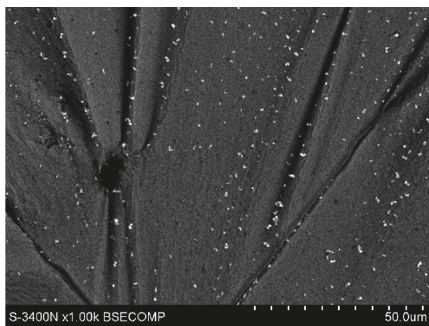
Figure 9: SEM micrograph of Pb 0.8/air sample: large Pb precipitates arranged along surface deformations.